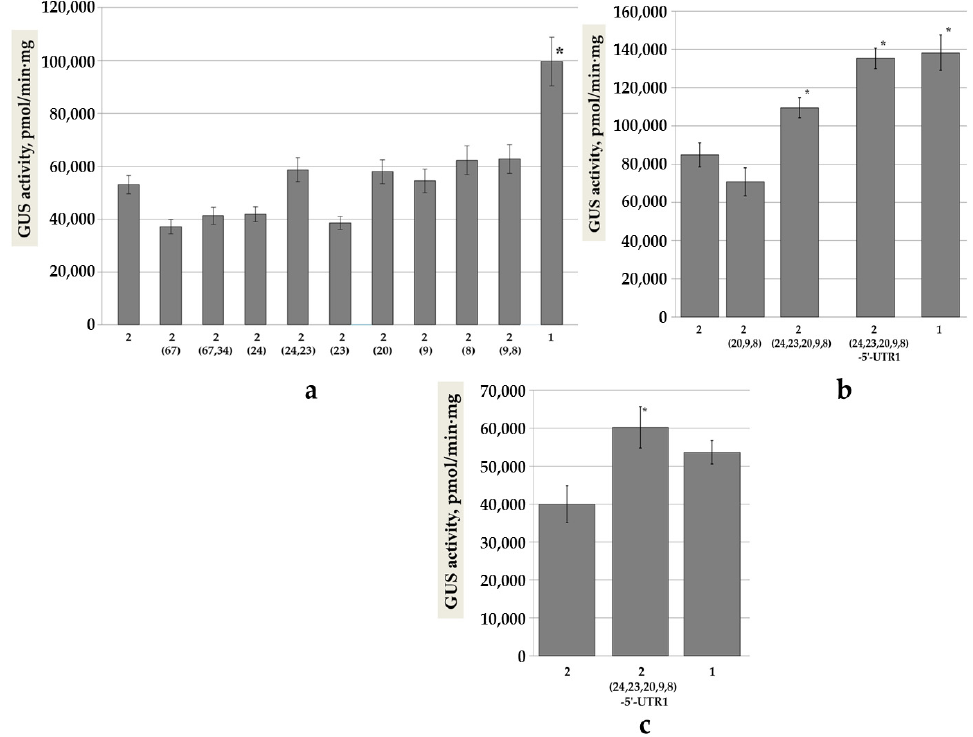
Figure 7. GUS activity from the uidA reporter expressed in N. benthamiana leaves in transient assays. The intact pro-SmAMP1 (102) and pro-SmAMP2 (104) promoters are indicated by the numbers 1 and 2, respectively. The variants created on the basis of pro-SmAMP2 (104) are designated as number 2 with the position of the introduced mutation(s) in parentheses. ( a ) Synthetic promoter variants with single and double bp mutations. The plants were grown in a 16-h light / 8-h dark photoperiod; ( b ) synthetic and chimeric variants with three or more mutations. The plants were grown in a 16-h light / 8-h dark photoperiod; ( c ) synthetic chimeric variant of the pro-SmAMP2 promoter with five mutations and the 5 (cid:48) -UTR from SmAMP1 . The plants were grown in an 8-h light / 16-h dark photoperiod. Vertical lines show standard errors, n = 32–60 for each construct. The asterisks mark the values that significantly exceed those for pro-SmAMP2 by Student’s t -test (* p =